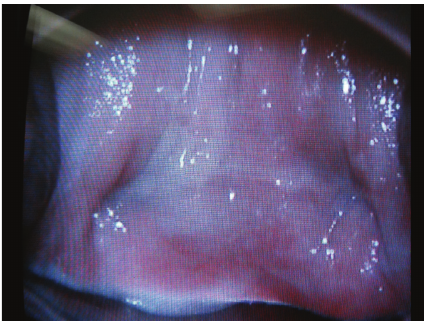
Figure 5: In this speculum exam photo from the six-week postoper- ative office check for granulation, good lateral apical support is seen bilaterally from the dimple caused by the uterosacral ligaments.